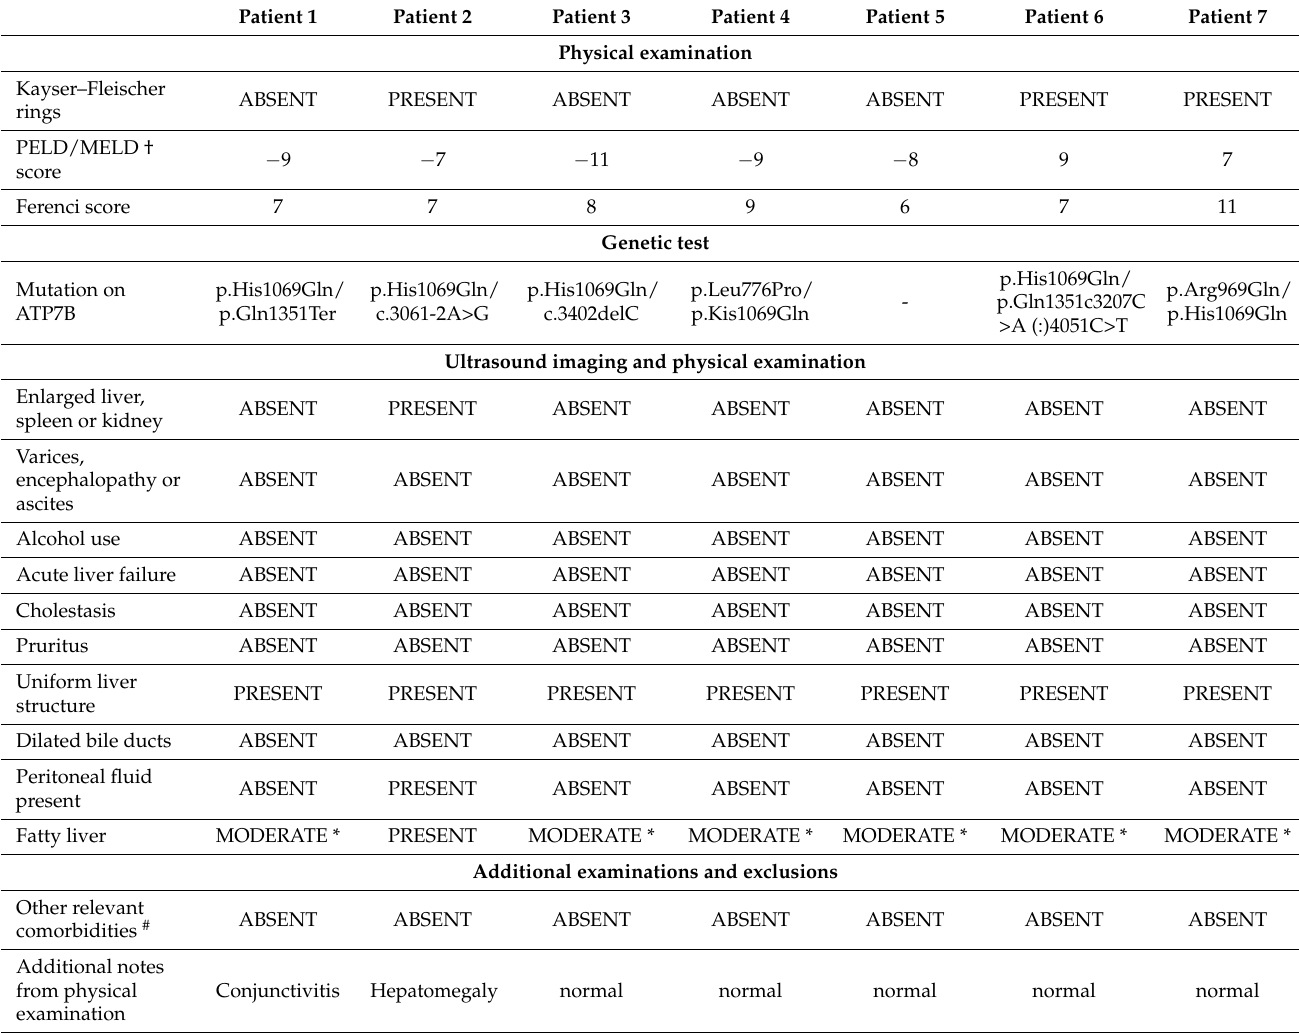
Table 2. Standard of care examination: clinical features, physical features, and ultrasound imaging